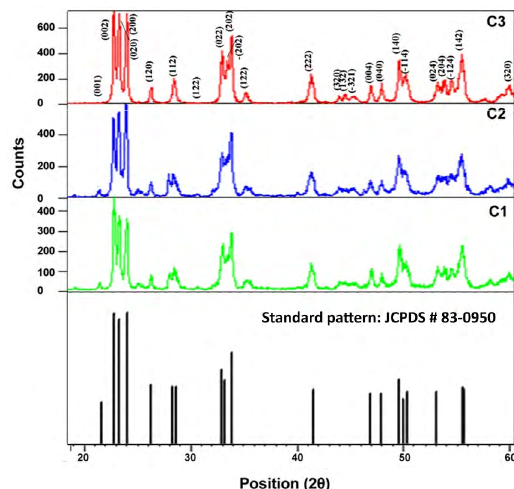
nano powders after calcination at 3